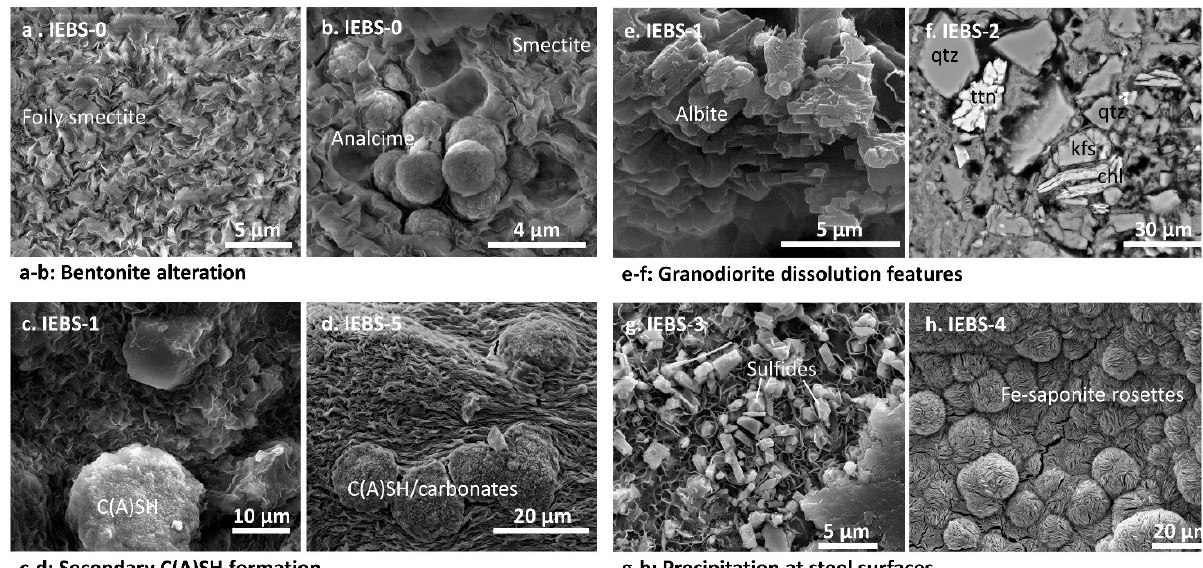
2 O, ~0.3 K 2 O, 0.2 to 0.5 wt. % CaO, and 0.1 to 0.2 wt. % F).